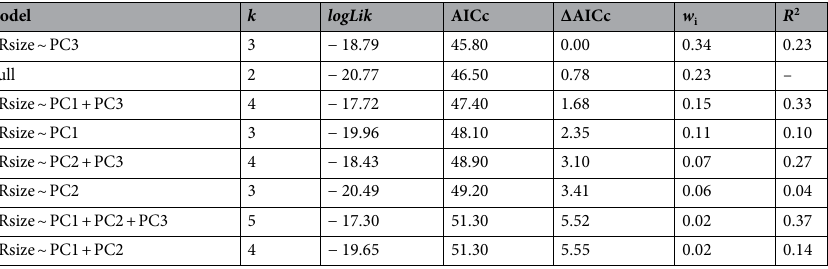
Table 3. Model selection summary of seven hierarchical linear regressions ranked by Akaike information criterion values corrected for small sample size (AICc) from the lowest to the highest value. Home range size (HRsize) of wintering whooper swans was used as the dependent variable, while the three behavioural PCs were used as predictors. K number of parameters included in the model, w i model weight, R 2 regression coefficient.